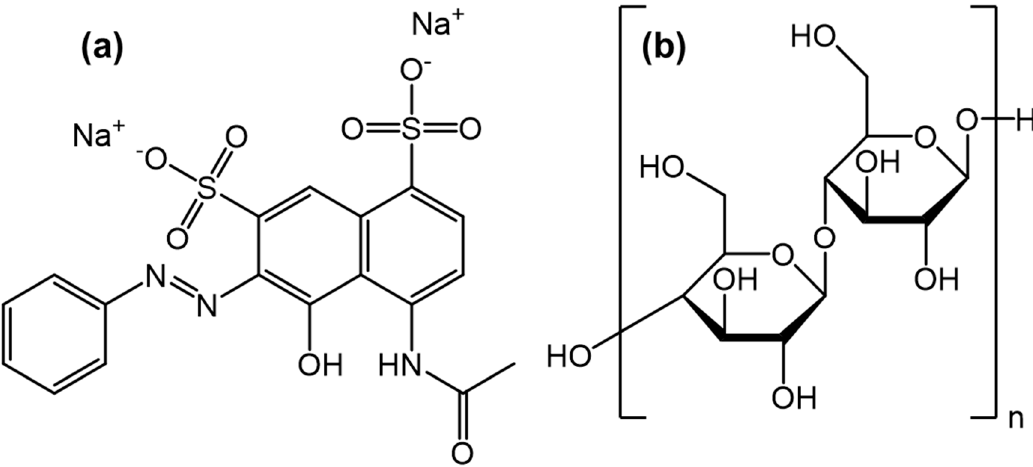
Figure 1. Model lignocellulosic biomass waste probe molecules: ( a ) Lignin Pink and ( b ) Cellulose Microcrystalline, derived from an α –cellulose precursor.